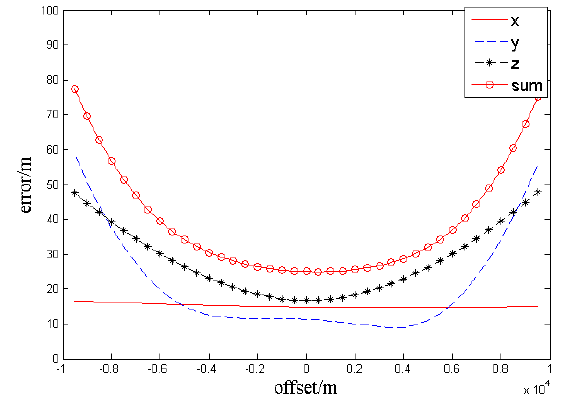
Figure 10. Error curves.